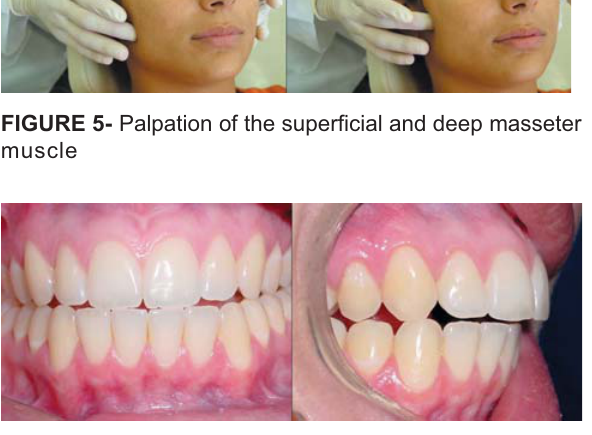
FIGURE 6- Anterior and lateral guide assessment